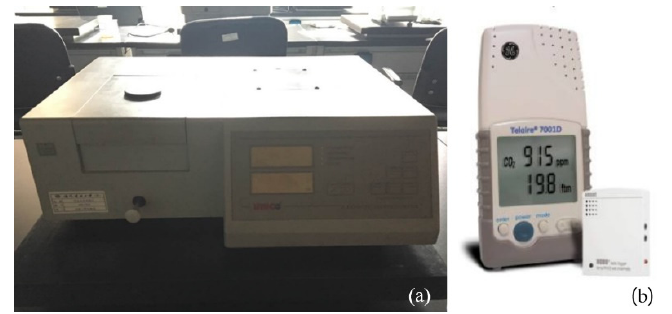
Table 3. Equipment information.